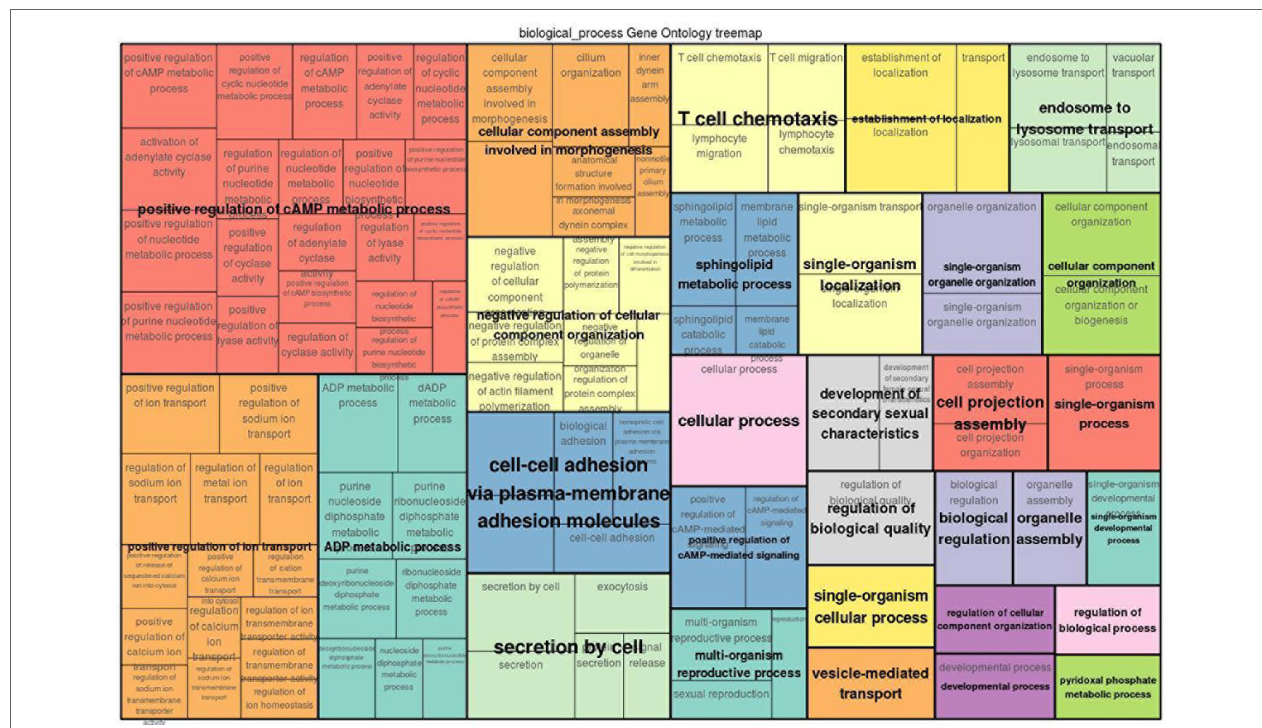
FIGURe 6 | GO treemap for the 260 functionally enriched ( P < 0.05) genes. The size of the boxes corresponds to the −log10 P -value of the GO-term. The boxes are grouped together based on the upper-hierarchy GO-term which is written in bold